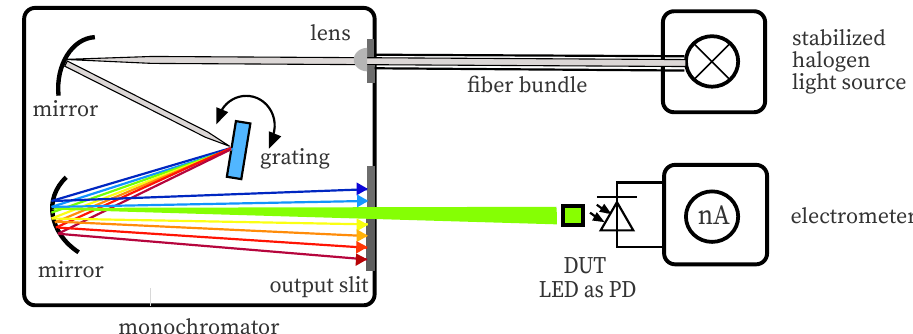
monochromator. The light output of the monochromators adjustable spectrum hits the device under test. The generated photocurrent is quantified by a nanoampere meter.